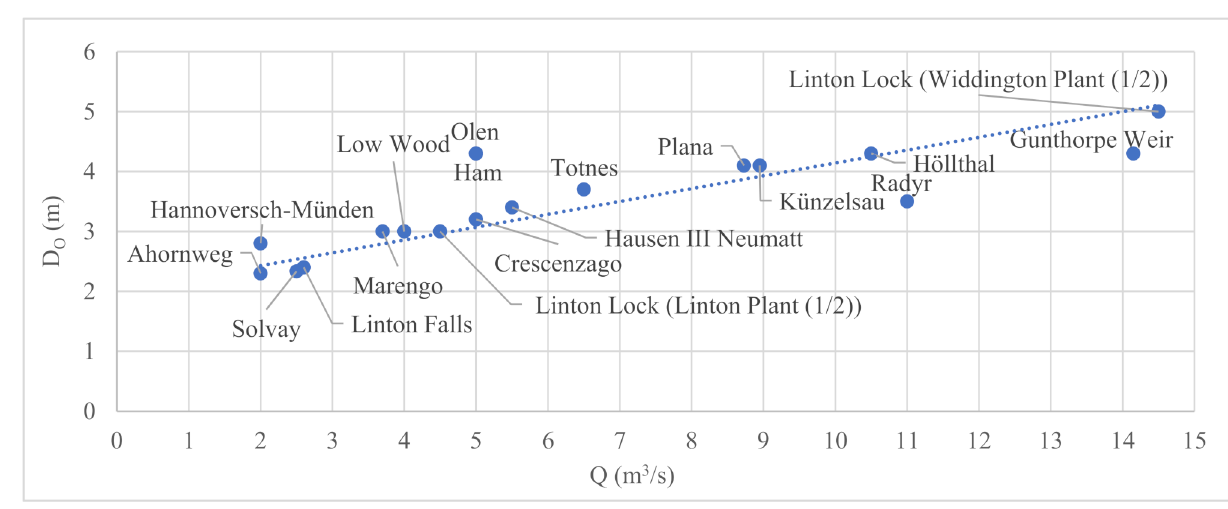
Figure 3. Comparison of the volumetric flow rate and diameter of installed screws in hydropower plants listed in Table 2. All values above are for a single screw.